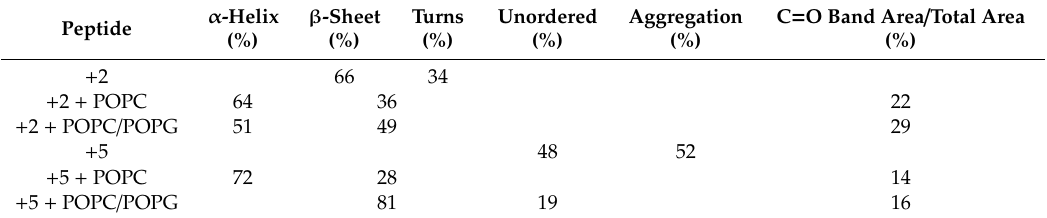
Figure 6. Amide I ′ band decomposition of the peptide +2 ( A ) and +5 ( B ) alone and in the presence of MLVs composed of POPC and POPC / POPG. Dashed lines are the individual Voigt bands fitted to the spectrum. The dotted lines represent the original absorbance amide I ′ bands and the continuous lines are the sum of the individual components. The red dashed lines are the C = O group absorption bands of the phospholipids. The numerical values are reported in Table 2. Table 2. Secondary structure composition of the peptide +2 and +5 in the absence and in the presence of model membranes as calculated by curve fitting of the amide I ′ band at RT.